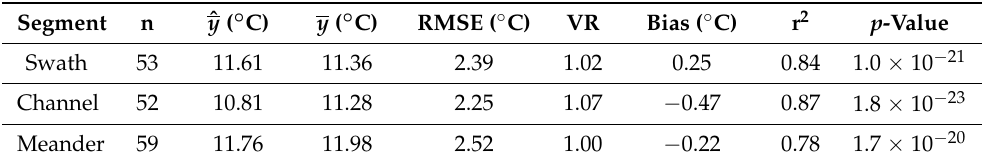
Table 1. Summary of agreement between Swath, Channel, and Meander AOI and USGS streamgage data. RMSE is the root mean squared error. VR is the variance